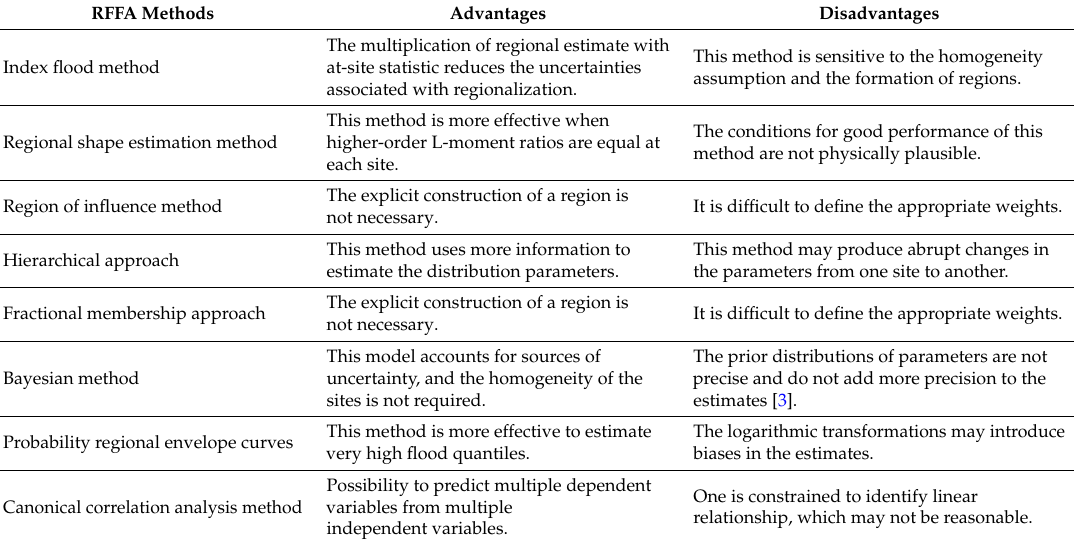
Table 1. Pros and cons of some regional flood frequency estimation methods. RFFA, flood frequency